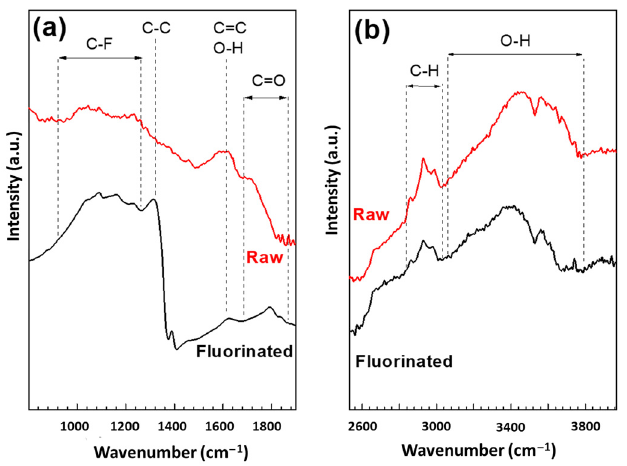
Figure 5. IR spectra of raw and fluorinated SCD in the two ranges of interest ( a , b ).